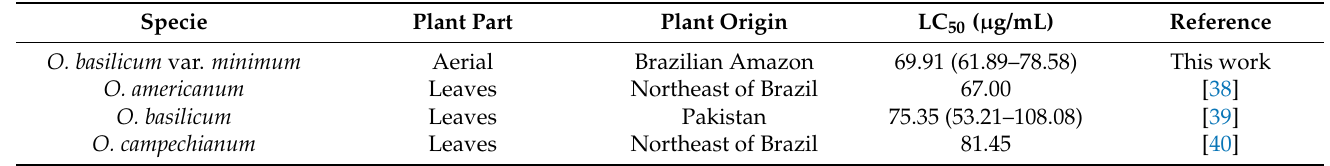
Table 2. Larvicidal activity of some essential oils of the genus Ocimum against Ae. aegypti